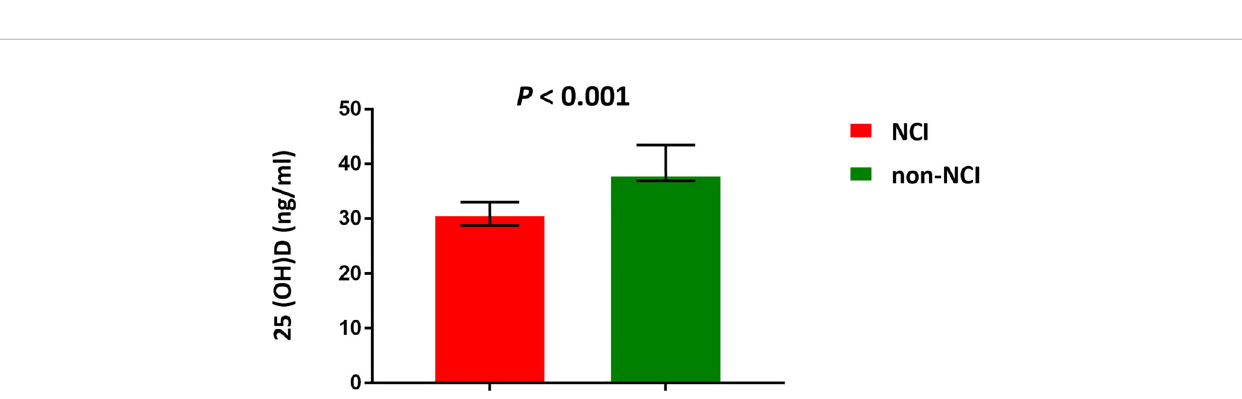
FIGURE 4 | Heat map summarizing the correlation of perturbed gut microbiota genera and altered fecal metabolites between the NCI and non-NCI groups. * P < 0.05; ** P < 0.01; *** P < 0.001.